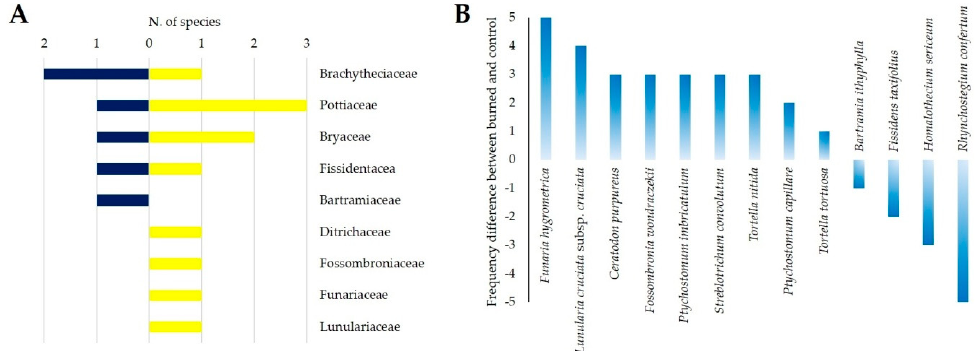
Figure 7. ( A ) Number of bryophyte species within each family in burned and control plots (total values). ( B ) Frequency changes of bryophytes species after the wildfire.